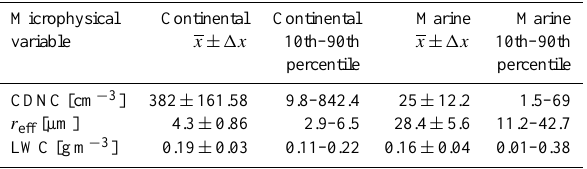
Table 1. For each microphysical variable (1st column) the table shows the mean value x with the related total uncertainty 1x (2nd and 4th column) and the 10th–90th percentile range of variability over the cloud lifetime (3rd and 5th